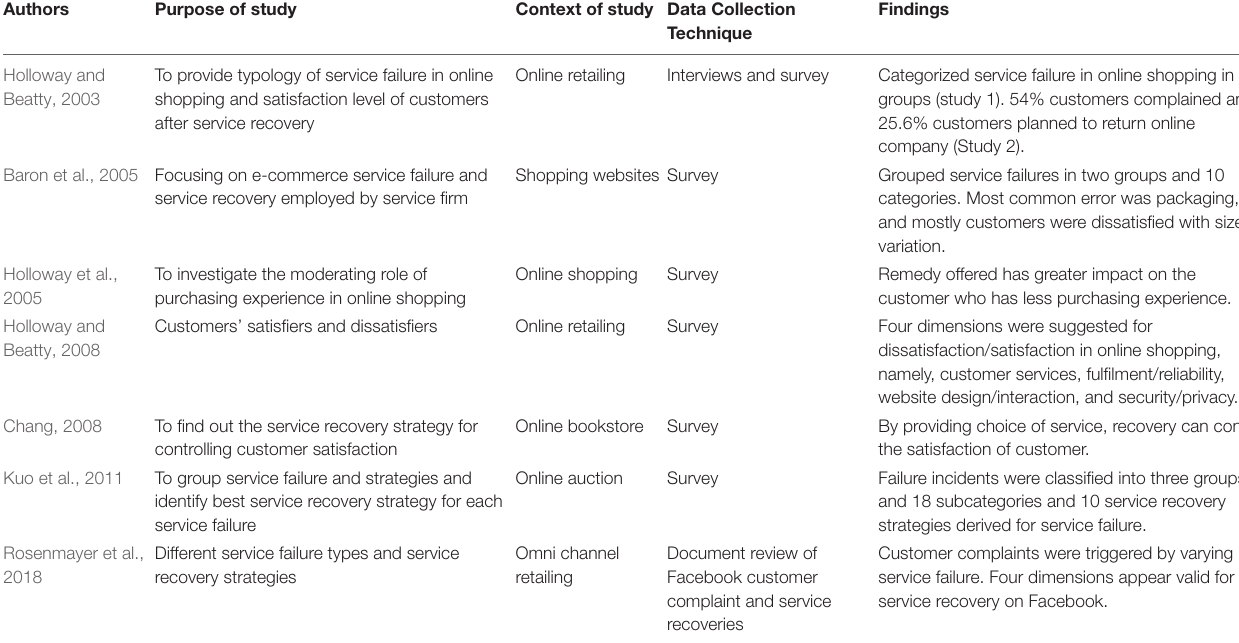
TABLE 2 | Service recovery studies on online